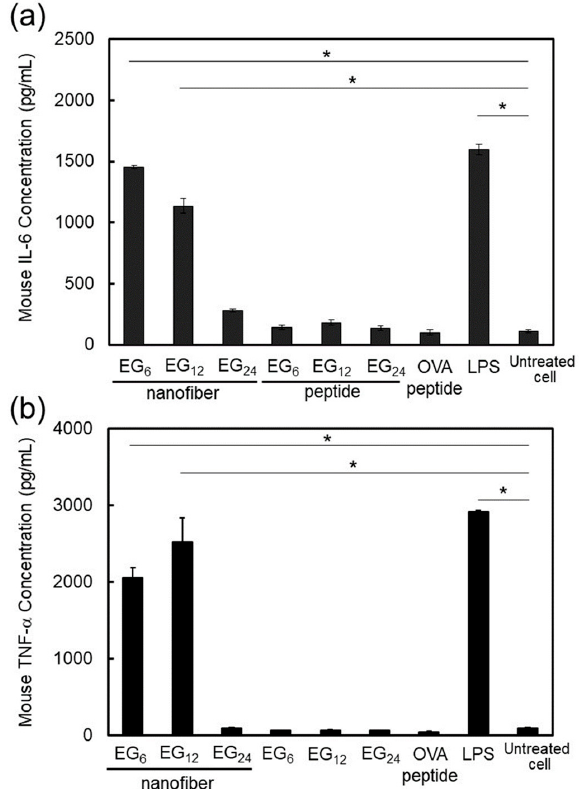
Figure 9. Quantification of immune-stimulatory cytokines secreted from JAWS II cells co-incubated with 10 μ M EG n NFs, 10 μ M EG n peptides, 10 μ M OVA peptide (SIINFEKL), or 1 μ g · mL ⁻ 1 LPS at 37 °C for 24 h. The cytokine levels ( a , b ) were measured by ELISA. Each result is the mean ± SD ( n = 3). * p < 0.01.